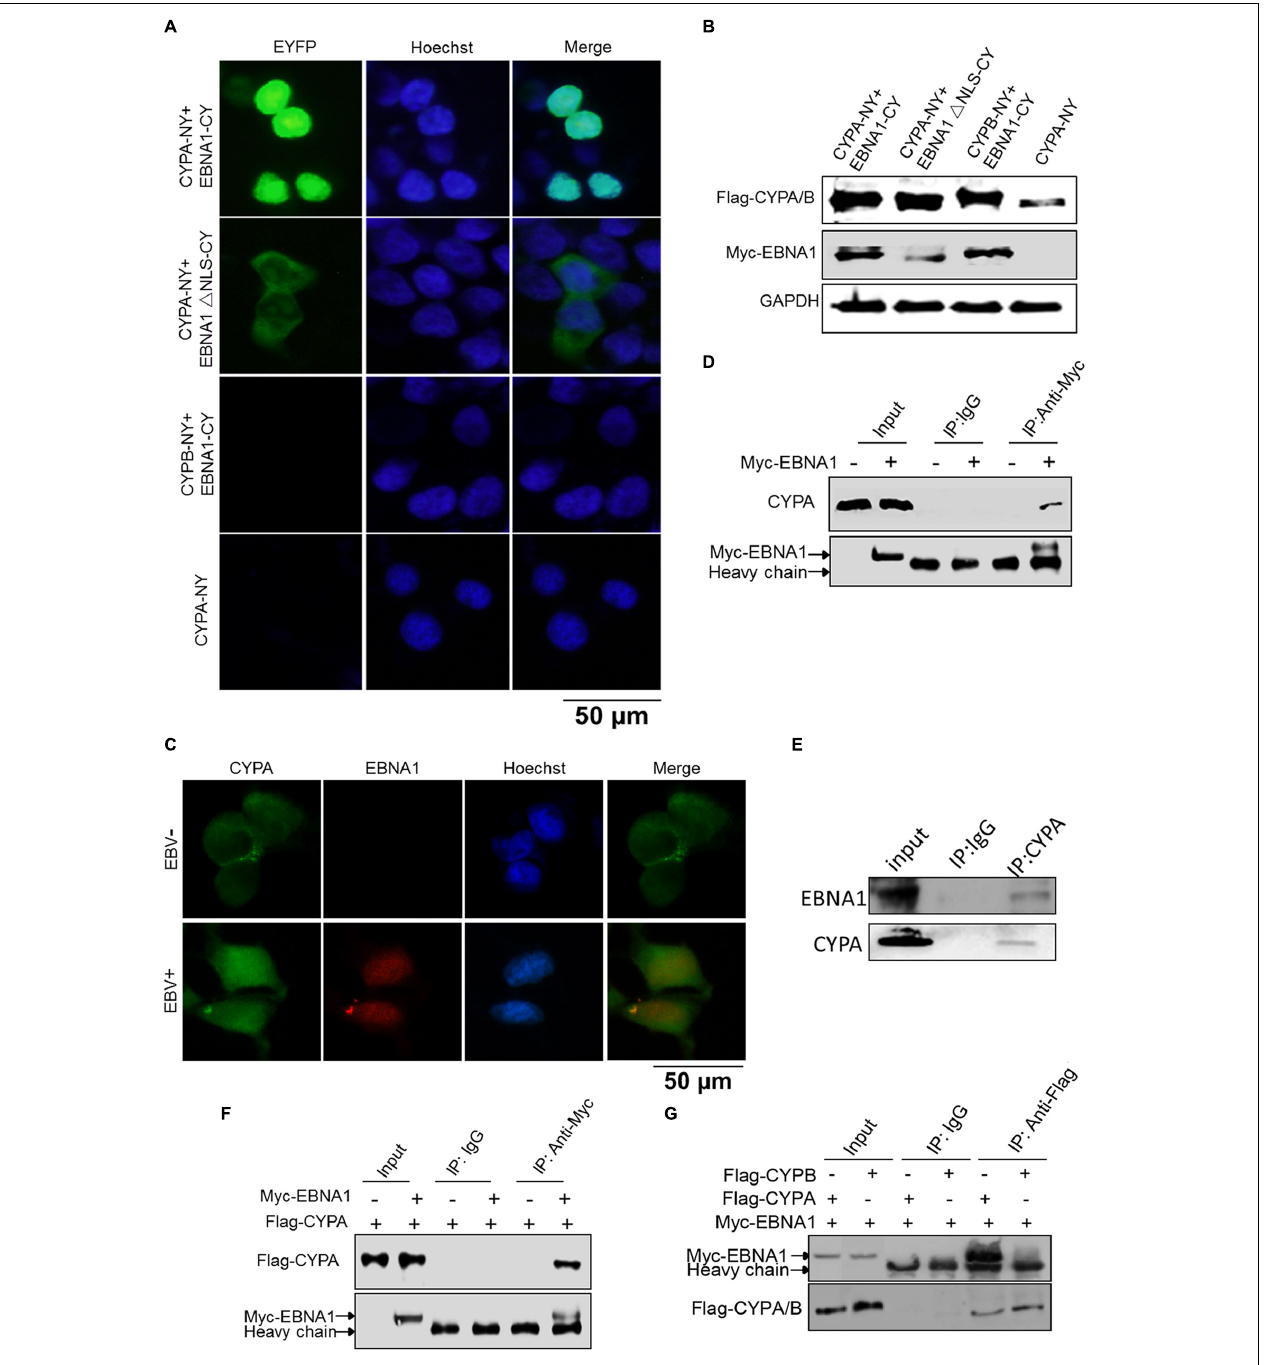
FIGURE 1 | Detection of CYPA-EBNA1 binding by the BiMC and co-IP assays. (A) Detection of the EBNA1-CYPA interaction by the BiMC assay. HEK293T cells were transfected with the indicated plasmids, including CYPA-NY, EBNA1-CY, EBNA1 (cid:49) NLS-CY, and CYPB-NY following by BiMC analysis, and fluorescence was observed. Transfection of a single CYPA-NY plasmid did not lead to the production of fluorescence. Scale bar, 50 µ m. (B) The proteins expressed from the plasmids used in the BiMC assay were detected by WB. (C) The detection of CYPA and EBNA1 in EBV-negative and EBV-positive HEK293 cells by IF assay. Scale bar, 50 µ m. (D) Endogenous CYPA interacts with EBNA1 in HEK293 cells. The plasmid pCAGGS-Myc-EBNA1 was transfected into cells. An anti-Myc antibody was used for the pull-down the CYPA, and the WB assay was carried out for detection. (E) Endogenous CYPA interacts with EBNA1 in C2089 cells. EBNA1 was immune-precipitated with anti-CYPA. EBNA1 was detected by WB (F) Exogenous CYPA interacts with EBNA1. HEK293 cells were transiently transfected with Flag-CYPA alone or with Myc-EBNA1. Flag-CYPA was immune-precipitated with anti-Myc antibody. IgG was used as a negative control for the pull-down in the co-IP assay. Flag-CYPA was detected by WB. (G) Co-IP assay for comparison of the interactions of CYPA and CYPB with EBNA1. PCAGGS-Myc-EBNA1 and pCAGGS-Flag-CYPA or pCAGGS-Flag-CYPB were transfected in HEK293 cells. Myc-EBNA1 was immune-precipitated with anti-Flag antibody.